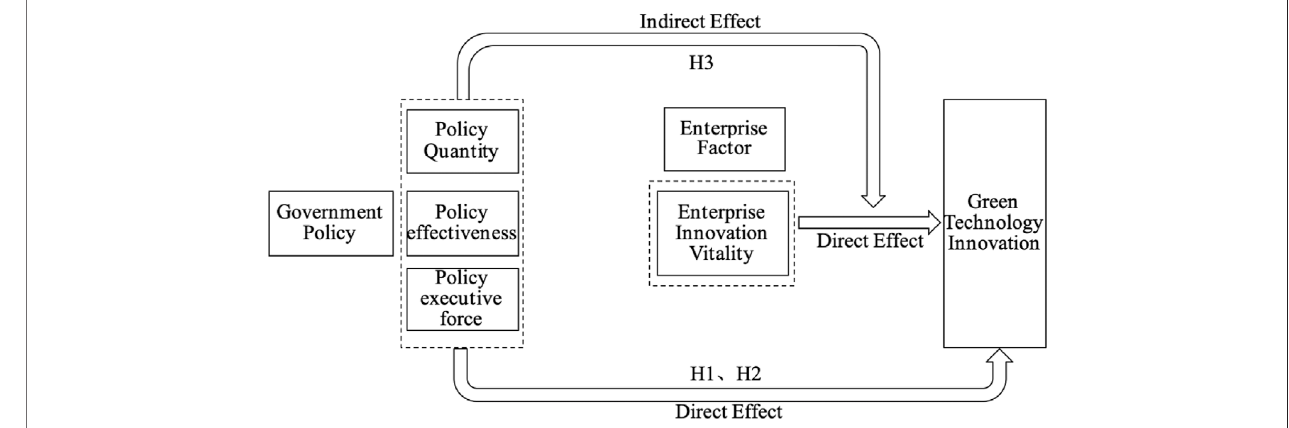
FIGURE 1 | Theoretical framework.